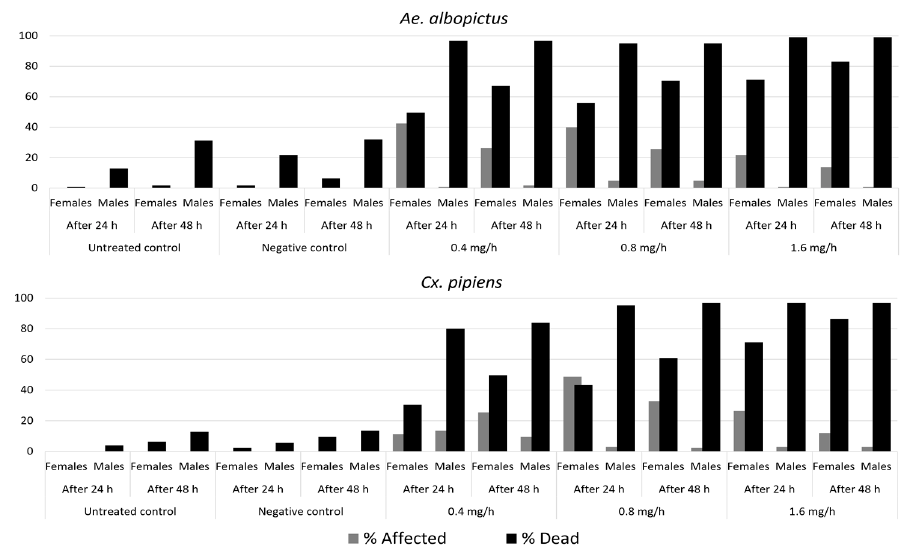
Figure 4. Percentages of affected and dead Ae. albopictus and Cx. pipiens at 24 and 48 h into the post-treatment period across the five treatment groups.